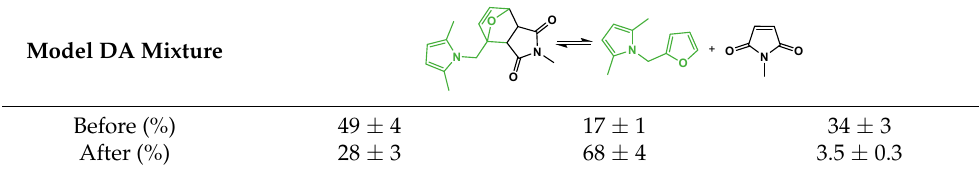
Table 1. Percentages of the model DA mixture obtained by 1 H-NMR before and after 3 h at 150 °C. Model DA Mixture